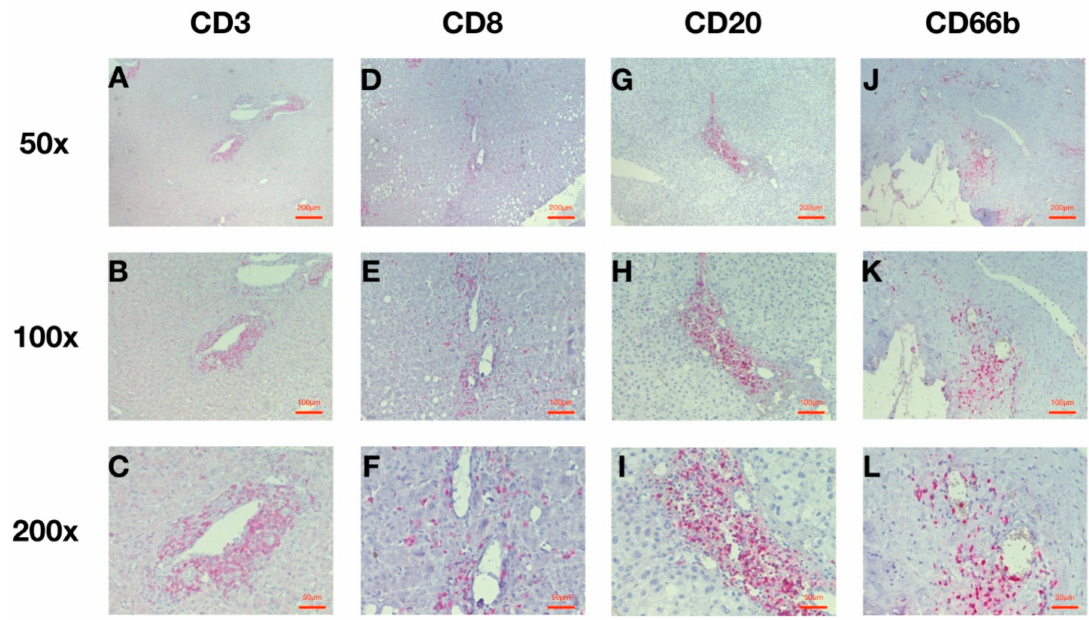
Figure 2. Representative Perivascular Patterns of CD3 + , CD8 + , CD20 + , and CD66b + Cells under 50 × , 100 × , and 200 × Magnifications. ( A ) CD3 at 50 × magnification; ( B ) CD3 at 100 × magnification; ( C ) CD3 at 200 × magnification; ( D ) CD8 at 50 × magnification; ( E ) CD8 at 100 × magnification; ( F ) CD8 at 200 × magnification; ( G ) CD20 at 50 × magnification; ( H ) CD20 at 100 × magnification; ( I ) CD20 at 200 × magnification; ( J ) CD66b at 50 × magnification ( K ) CD66b at 100 × magnification; ( L ) CD66b at 200 ×